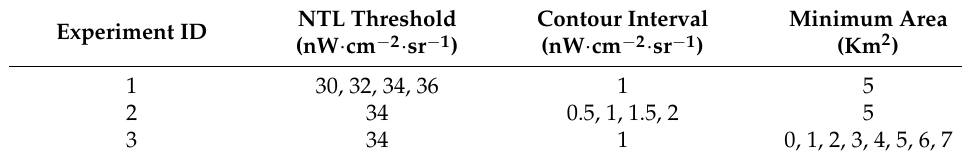
Table 4. A specific description of the nine nighttime lighting statistics